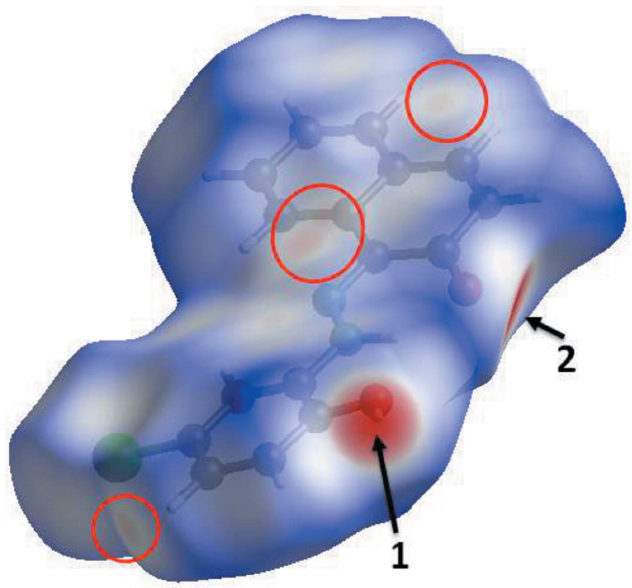
Figure 4 Hirshfeld surface mapped over d norm for the title compound in the range (cid:5) 0.728 to +1.258 arbitrary units.